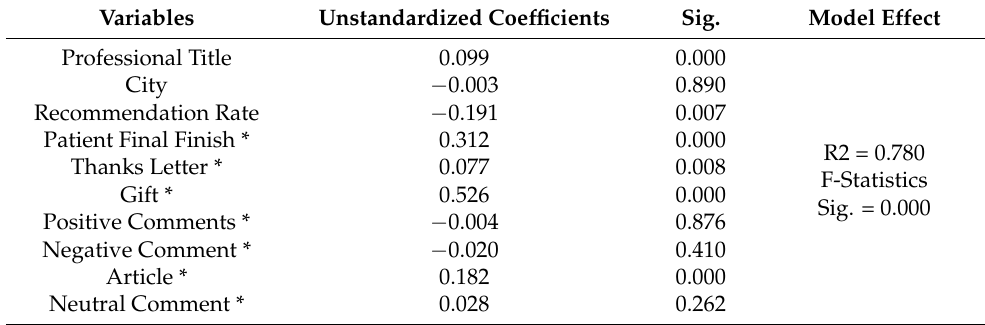
Table 4. Regression Coefficient (Group